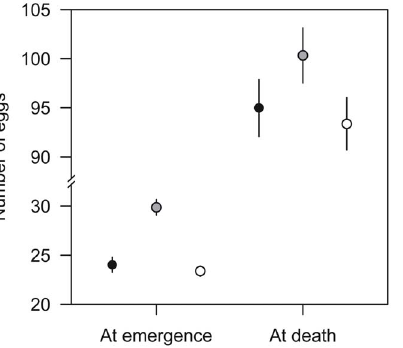
Figure 2. Means 6 SEM of egg load at emergence and at death. Means and SEM are calculated for observed values minus the predictions for random effects of a model with cross type, body size and their interaction as fixed effect and paternal and maternal populations as random effects (egg load at emergence) or a model with body size as fixed effect and maternal population and block as random effects (egg load at death). Means for within-family, between- family and between-population crosses are represented by black, grey and empty circles, respectively. For egg load at emergence, least-square means were higher for between-family crosses than for other crosses (within-family/between-family: z=2.92, p =0.0097; within-family/be- tween-population: z= 2 0.26, p =0.9627; between-family/between-pop- ulation: z=3.14, p =0.0049).